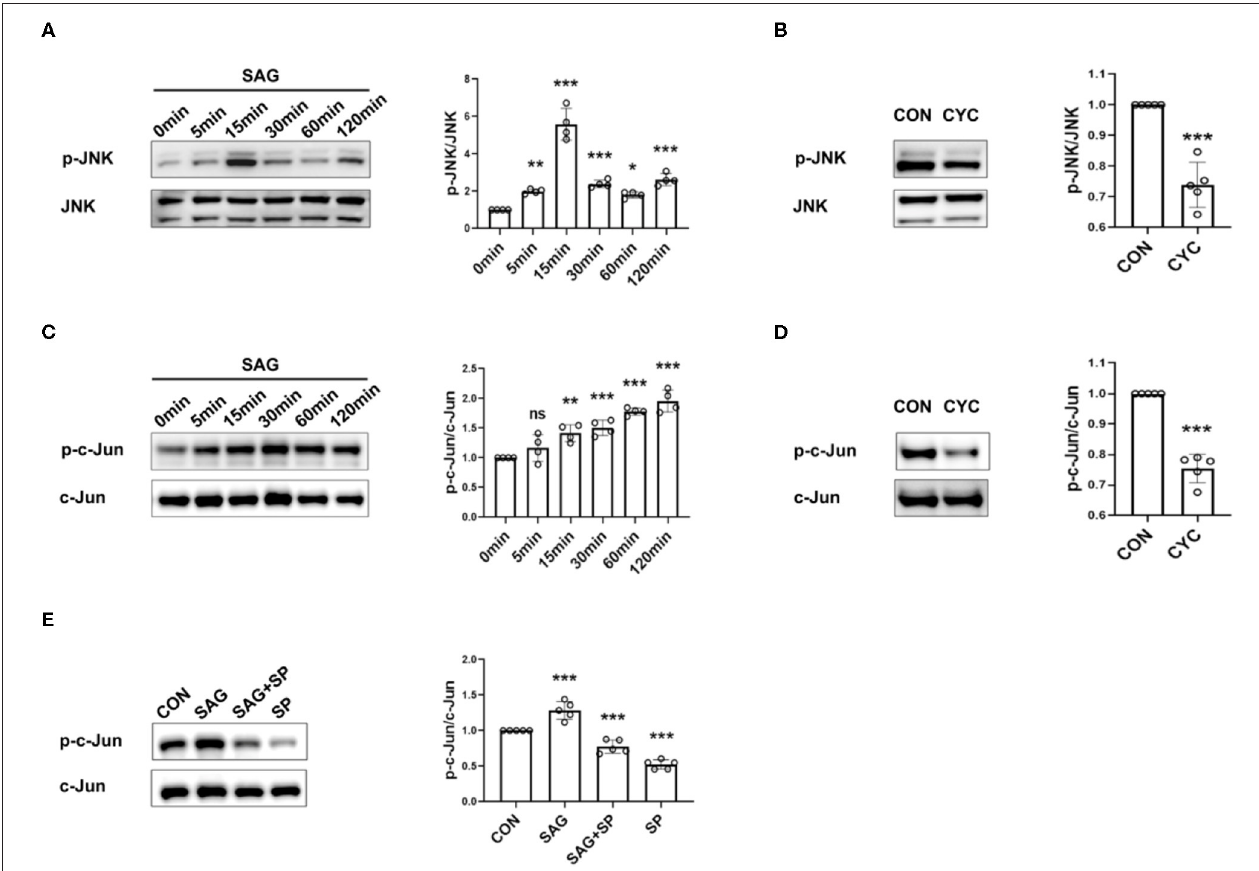
FIGURE 2 | SHH agonist and antagonist regulate JNK signaling. (A–E) Effects of SHH agonist (SAG) and antagonist (cyclopamine) on the phosphorylation of JNK and c-Jun were evaluated by Western Blot. FLSs were stimulated with SAG (1 µ M) at different time points (5, 15, 30, 60, 120min) and the levels of phospho-JNK and phospho-c-Jun were determined by Western Blot ( n = 4) (A,C) . To detect the effect of SHH antagonist on JNK signaling, FLSs were treated with cyclopamine (10 µ M) for 24 and 48h before the levels of phospho-JNK (B) and phospho-c-Jun (D) were detected, respectively ( n = 5). The expression of phospho-c-Jun was evaluated after FLSs were treated with SAG in the presence of JNK inhibitor SP600125 for 15min ( n = 5) (E) . Results were normalized to the levels of total JNK or c-Jun. FLSs in control group were treated with vehicle (DMSO supplemented in DMEM with 10%FBS). The results are shown as the mean ± S.D. Data were analyzed using ANOVA with Dunnett’s post hoc test (A,C,E) or independent sample Student’s t -test (B,D) . * P < 0.05 vs. control group. ** P < 0.01 vs. control group. *** P < 0.001 vs. control group. ns, non-significant; CON, control group; CYC, cyclopamine; SP, SP600125.